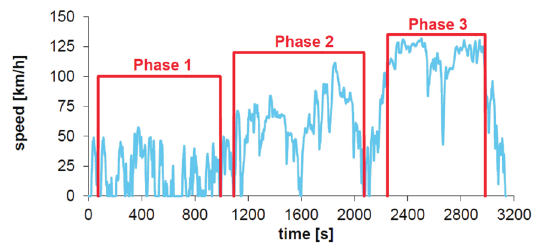
Fig. 4. CADC driving cycle